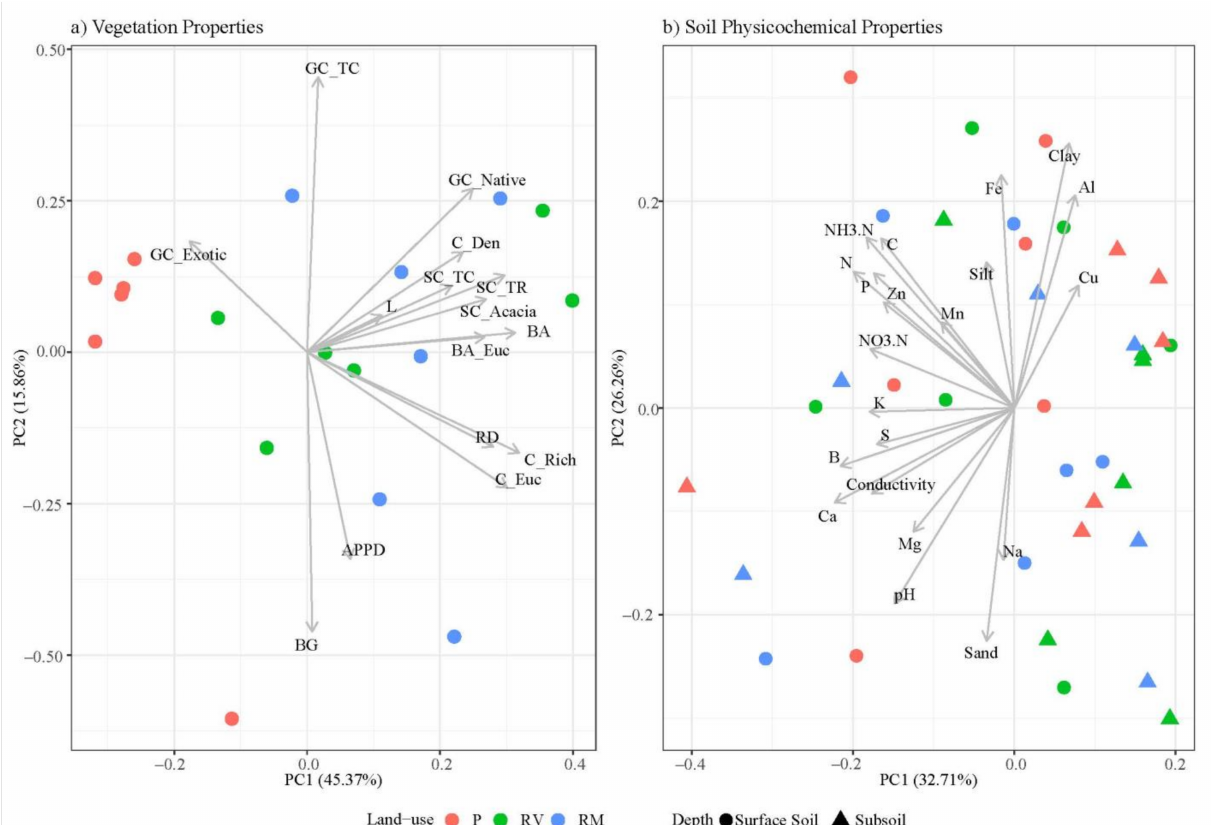
Figure 2. PCA of ( a ) vegetation properties and ( b ) soil physicochemical properties. Points are colored based on land use (red = pasture (P), green = revegetated (RV), and blue = remnant (RM)) with symbols distinguishing soil depth (circle = surface soil and triangle = subsoil). Abbreviations for vegetation are described in Table 2 and those for soil in Table